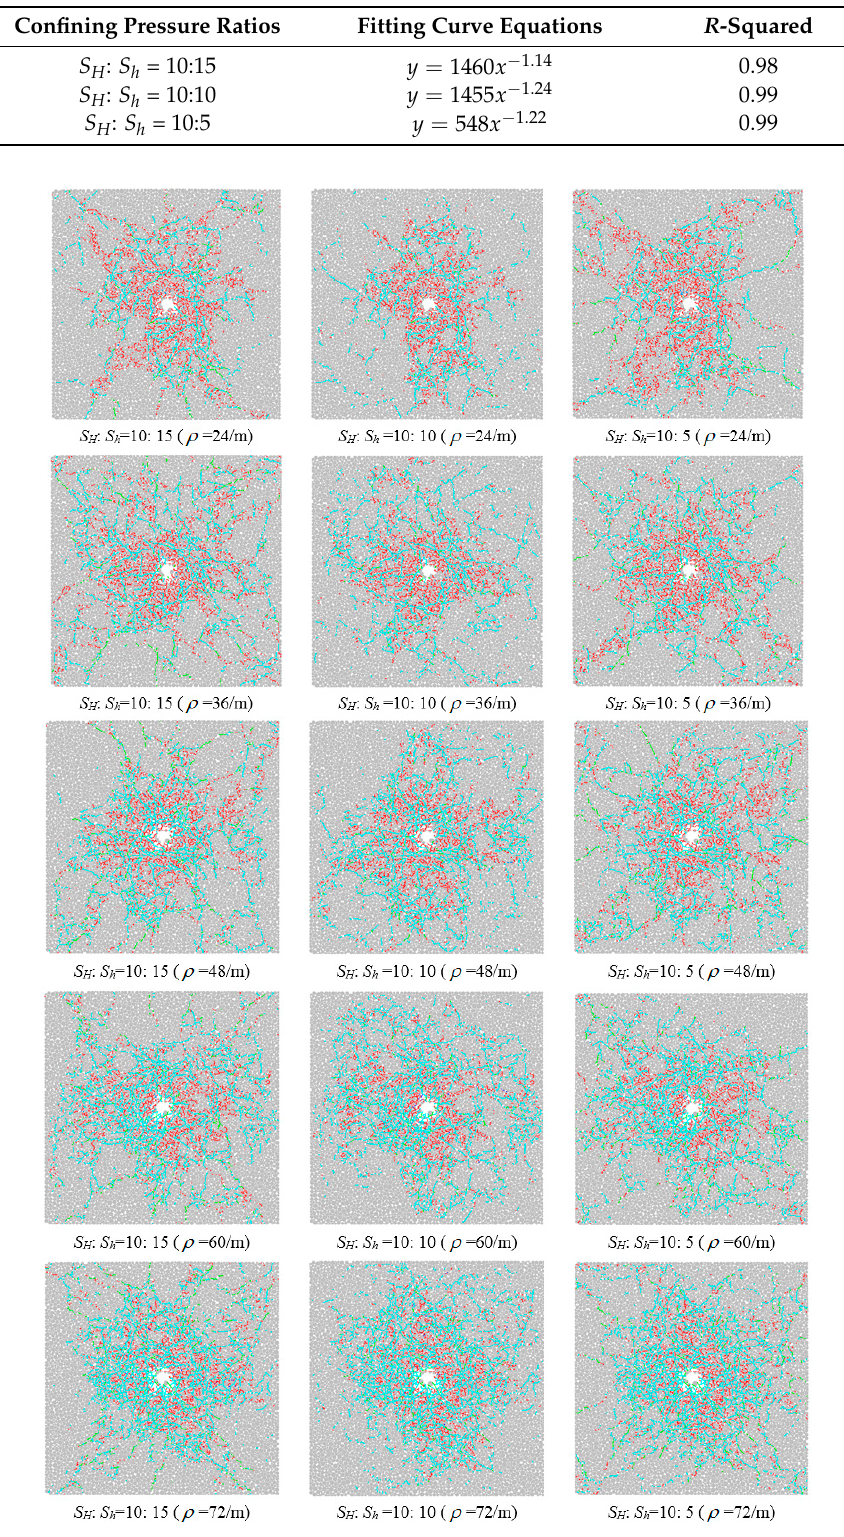
Figure 22. Change of crack distribution with confining pressure ratio when NF density ranges from 24/m to 72/m and injection rate is 2.0 × 10 − 6 m 3